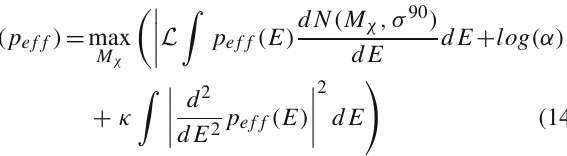
( E ) , p 1 ( E ) and excluded cross section for SI interactions obtained with p 0 ef f ef f ( E ) (green-dash)and p 2 dash), p 1 Xe ) efficiency corre- ef f XENON1T